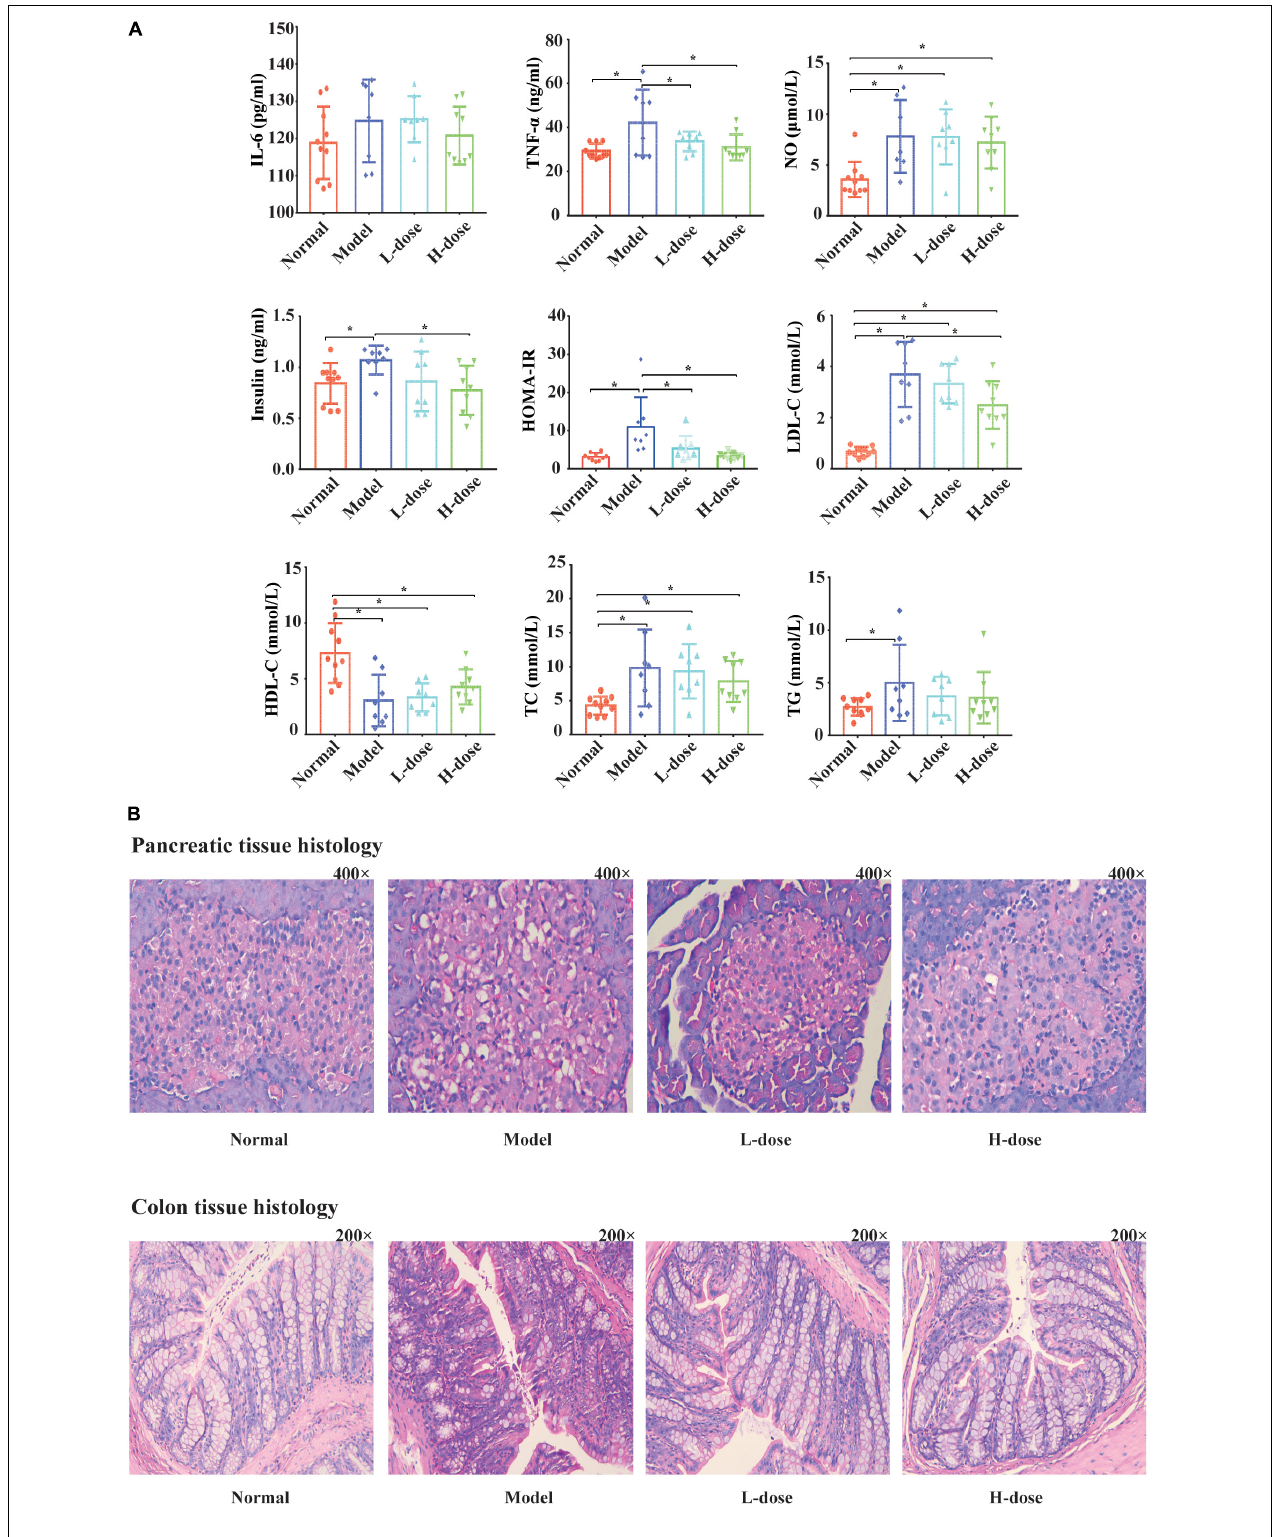
FIGURE 1 | Probiotics supplements restore the normal serum parameters and pancreatic and colon histology influenced by GDM. (A) The concentrations of IL-6, TNF- α , NO, insulin, HOMA-IR, LDL-C, HDL, TC, and TG in GDM rats and GDM rats treated with Lactobacillus and Bifidobacterium probiotics supplements were tested. (B) The hematoxylin-eosin staining sections of the pancreas tissue and the colon tissue in GDM rats and GDM rats treated with probiotics supplements. * P < 0.05.